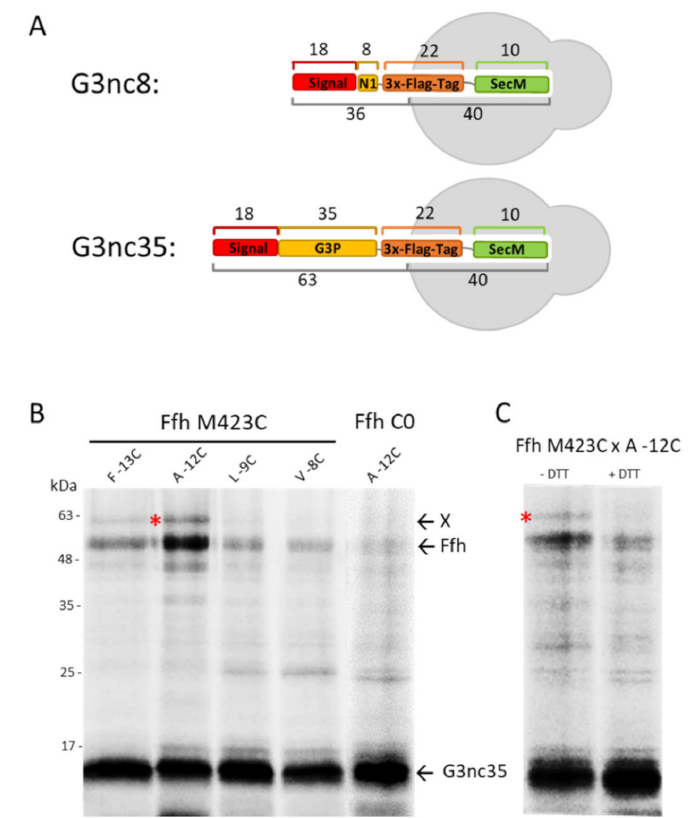
Figure 3. Interaction of G3p nascent chain with SRP in vivo. ( A ) A ribosome-nascent chain (RNC) was constructed with G3p encompassing the signal sequence and the first 35 amino acid residues of the mature protein, followed by a sequence encoding a triple Flag-tag (22 residues) and a SecM stalling sequence of 10 residues. ( B ) Coexpression of the nascent chain G3nc35 and Ffh in E. coli MC-dFfh. The exponentially growing cells were pulse-labelled with 35 S-methionine/cysteine for 2 min and immunoprecipitated with a Flag-tag antibody. Single cysteine mutants at the signal sequence positions − 13, − 12, − 9, − 8 of G3nc35 were coexpressed with Ffh423C or Ffh without cysteine for a control. ( C ) Coexpression of G3nc35(-12C) with Ffh423C as in ( A ), analysed on PAGE in the absence or presence of dithiothreitol (DTT). The crosslinked G3p-Ffh product is marked with red